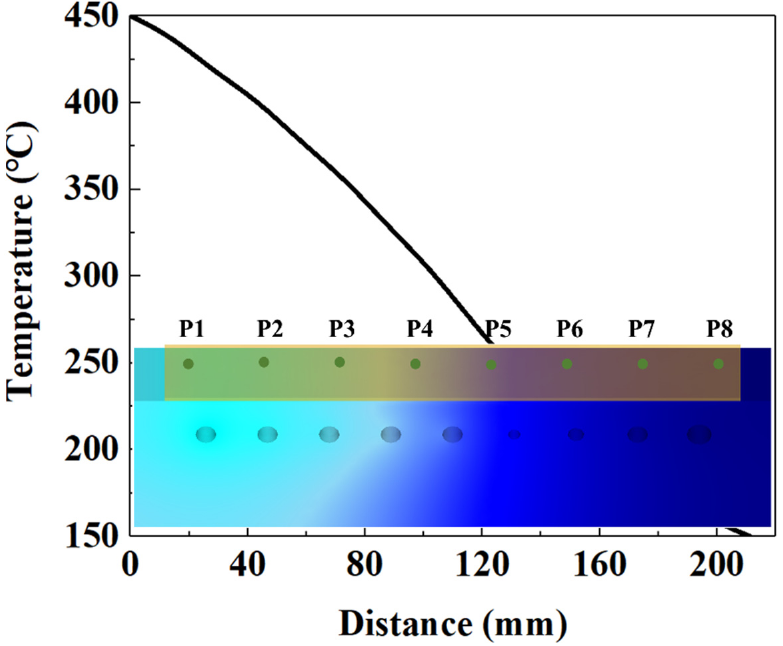
Figure 8. Temperature distribution of die surface and eight temperature measuring points of